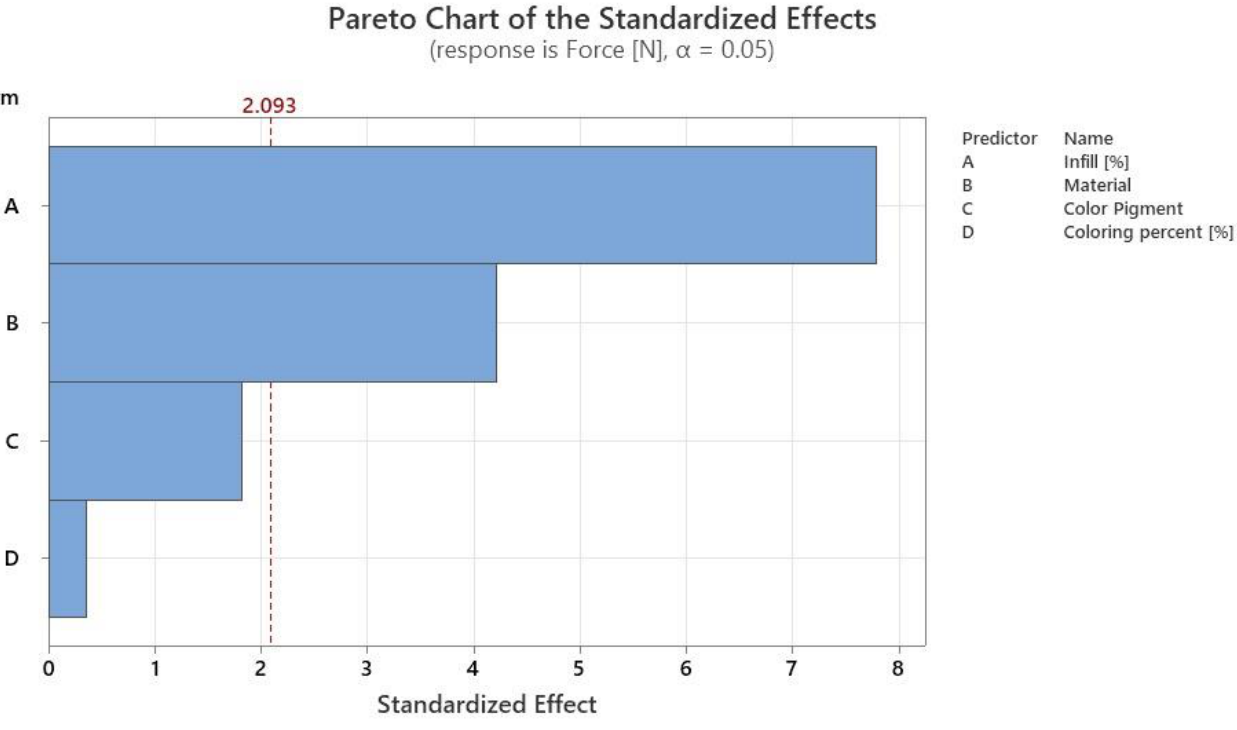
The ANOVA analysis allowed us to draw a Pareto chart (Figure 14), which shows the level of significance of each factor used in the experimental design presented in Section 2.